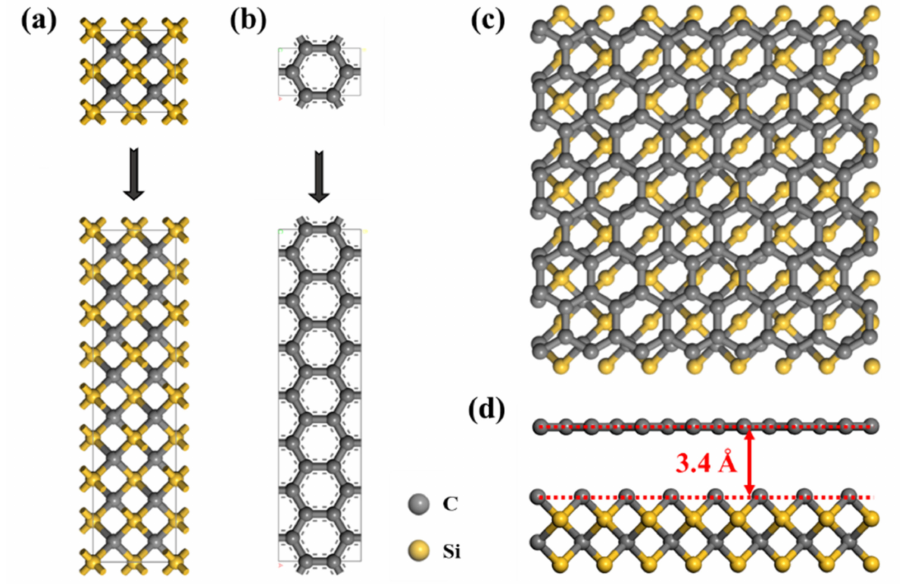
Figure 1. Top views of SiC ( a ), graphene ( b ) and GS-Hs ( c ). The interlayer distance between graphene and SiC is 3.4 Å ( d ). The yellow and gray balls represent Si and C atoms, respectively.